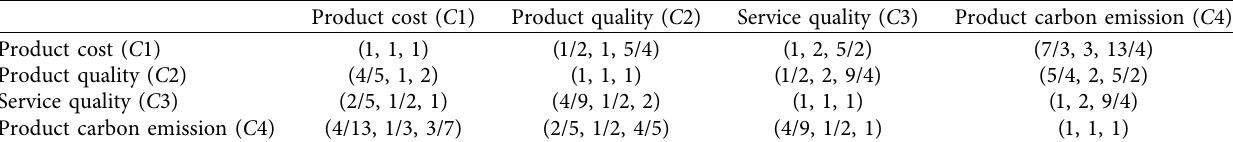
Table 2: Fuzzy judgment matrix of expert evaluation